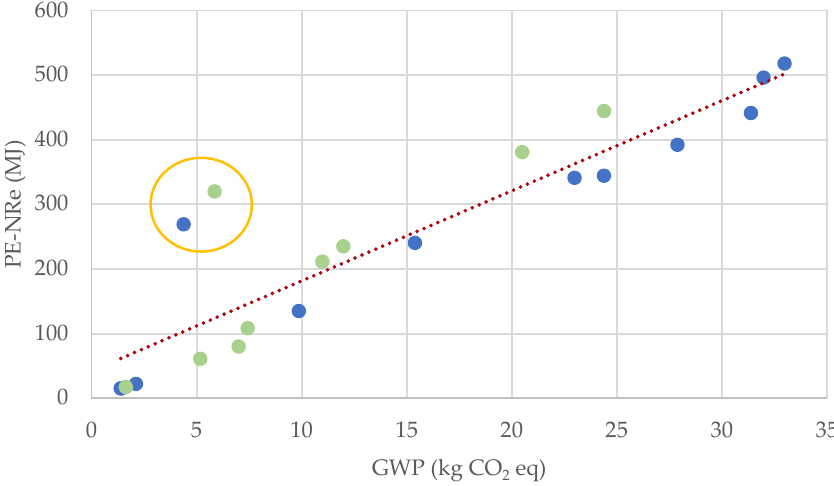
Figure 1. GWP vs. Pe-NRe, per tonne of aggregate. Data from the EI appraised in this literature review (blue for NA and green for RA).